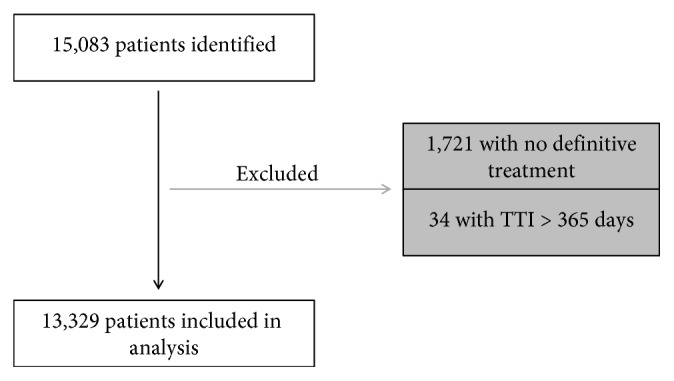
Inclusion and exclusion criteria (TTI, time to treatment initiation).